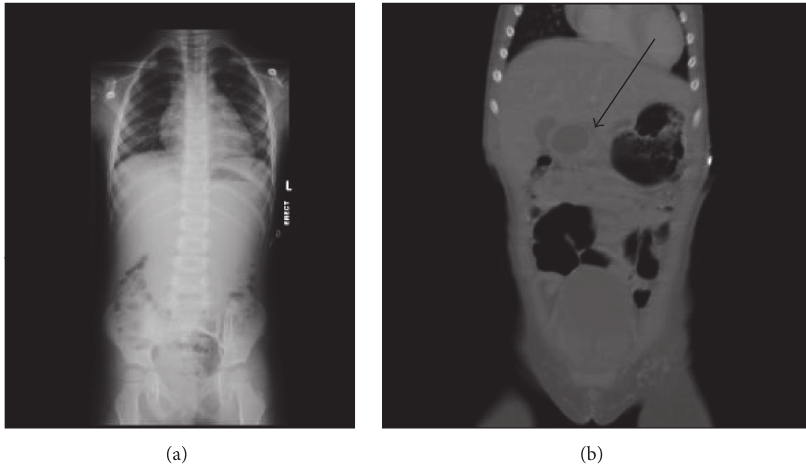
Figure 1: (a) Obstruction series. (b) CT with PO and IV contrast.